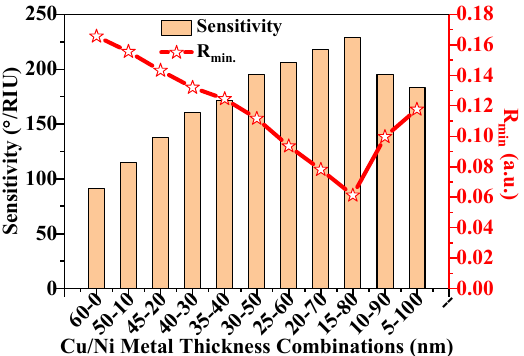
Figure 2. Bi-metal layer thickness optimization curve: sensitivity and R min vs. bilayer thickness.